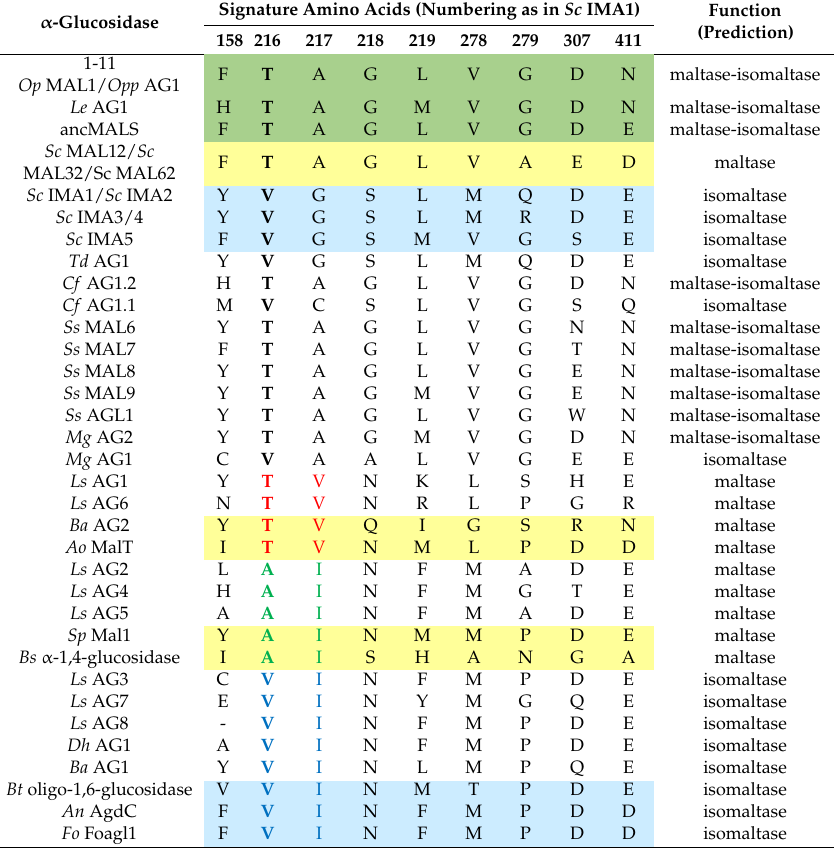
Table 2. Signature amino acids of α -glucosidases (AGs) and prediction of substrate specificity. Background coloring is as follows: maltases (yellow), isomaltases (blue), maltase-isomaltases (green), enzymes not studied experimentally before this study (white). The key position of Sc IMA1 (Val216) is shown in bold. Characteristic motifs T 216 V 217 , A 216 I 217 , and V 216 I 217 of AGs are shown in red, green, and blue letters, respectively. Bs , Bacillus stearothermophilus ; Bt , Bacillus thermoglucosidasius ; Ao , Aspergillus oryzae ; Fo , Fusarium oxysporum ; An , Aspergillus niger . See Table S1 for acronyms of AGs. Signature Amino Acids (Numbering as in Sc α -Glucosidase